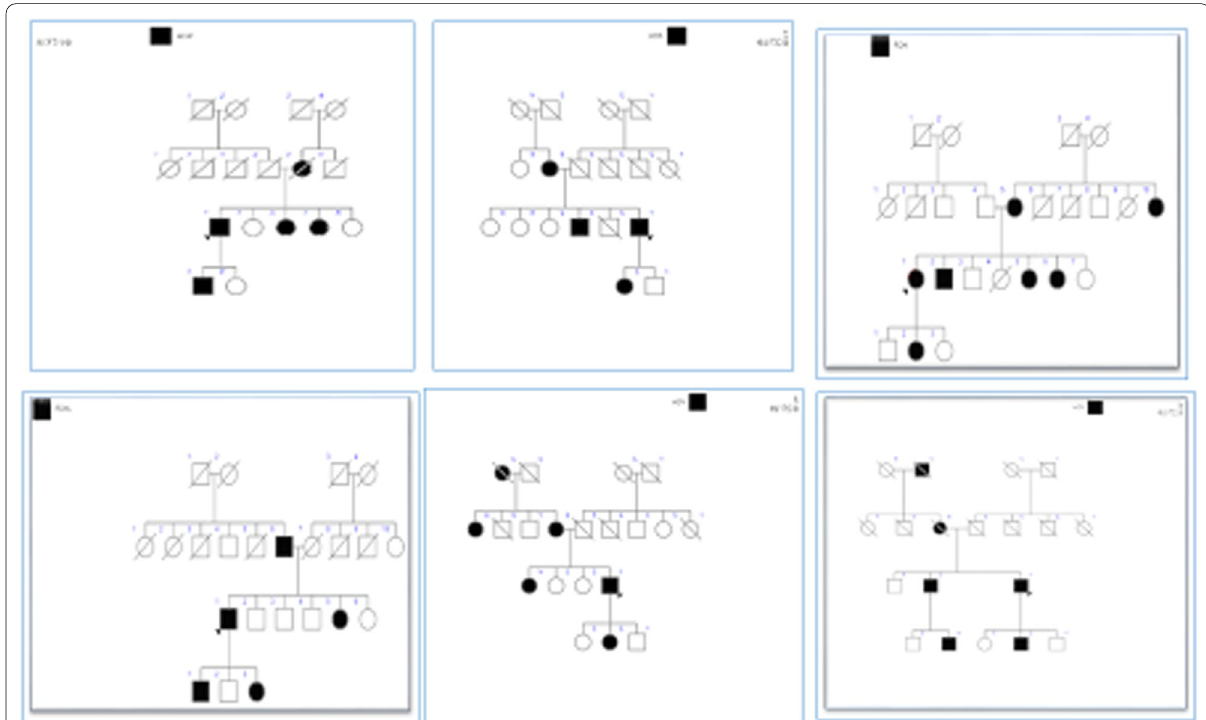
Fig. 1 pedigrees of studied pedigrees from 1 to 6, Circles indicate female family members and squares male family members; slashes indicate that the family member is deceased. Family members with FCHL disease are indicated by solid symbols and those without FCHL indicated by open symbols. FCHL, familial combined